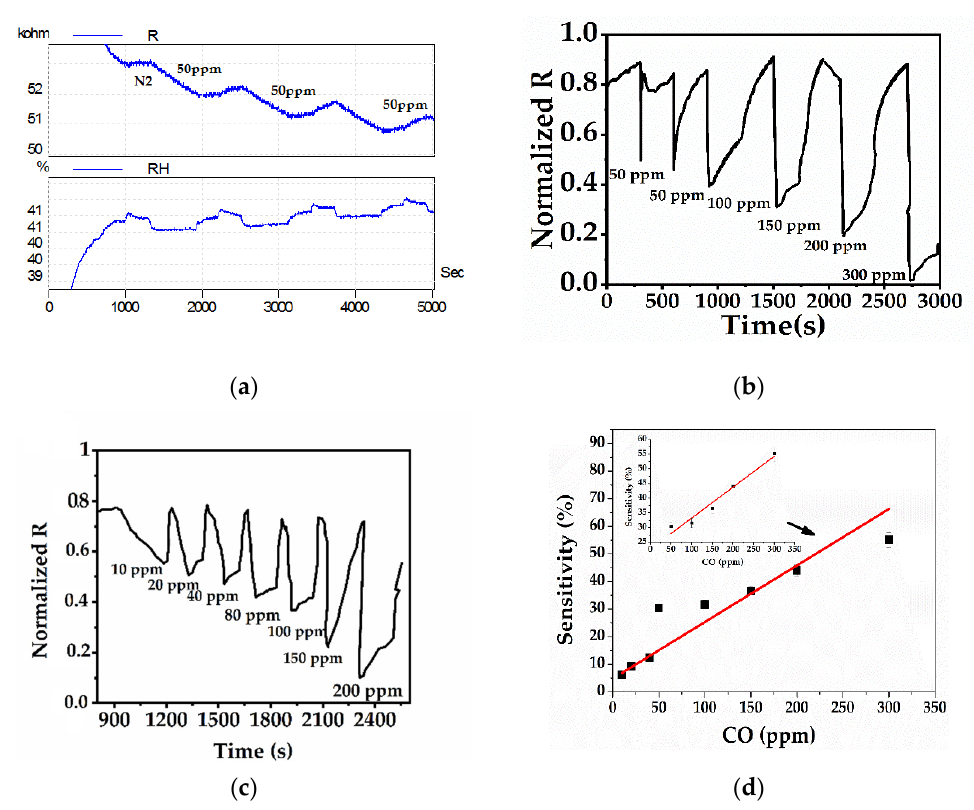
Figure 10. ( a ) The sensor behavior at a 40% relative humidity after three 50 ppm consecutive concentrations; ( b ) normalized values of resistances of sensor response [0,1] at low CO concentrations; ( c ) normalized values of resistances of sensor response [0,1] at high CO concentrations; ( d ) sensitivity variation of PANI:PSS/SWCNT/Fc with